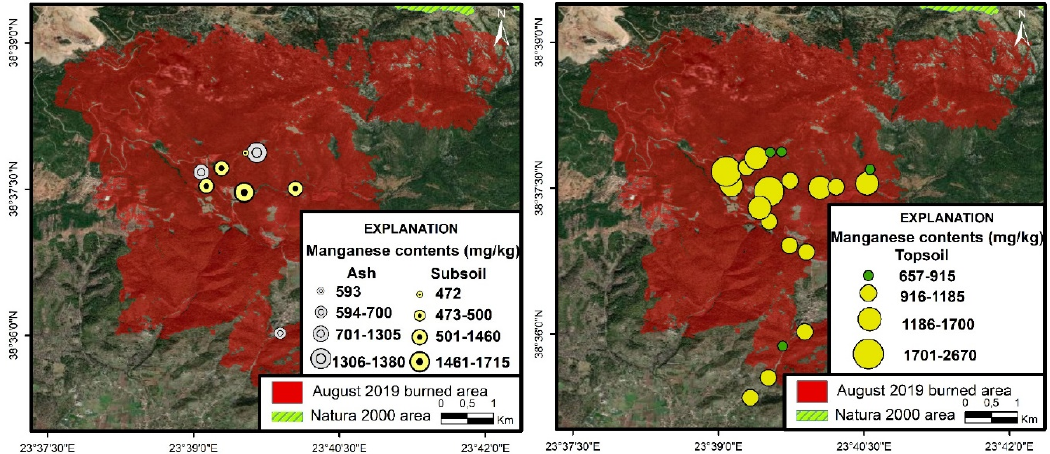
Figure 6. Map presenting manganese contents in ash, topsoil and subsoil at the study area (modified from [23,24,26]).